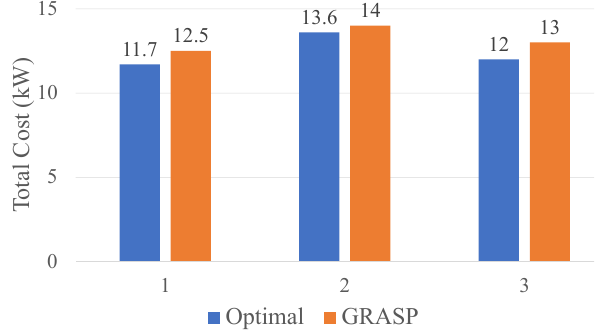
Figure 5. Cost comparison between the optimal solution and GRASP on the simple